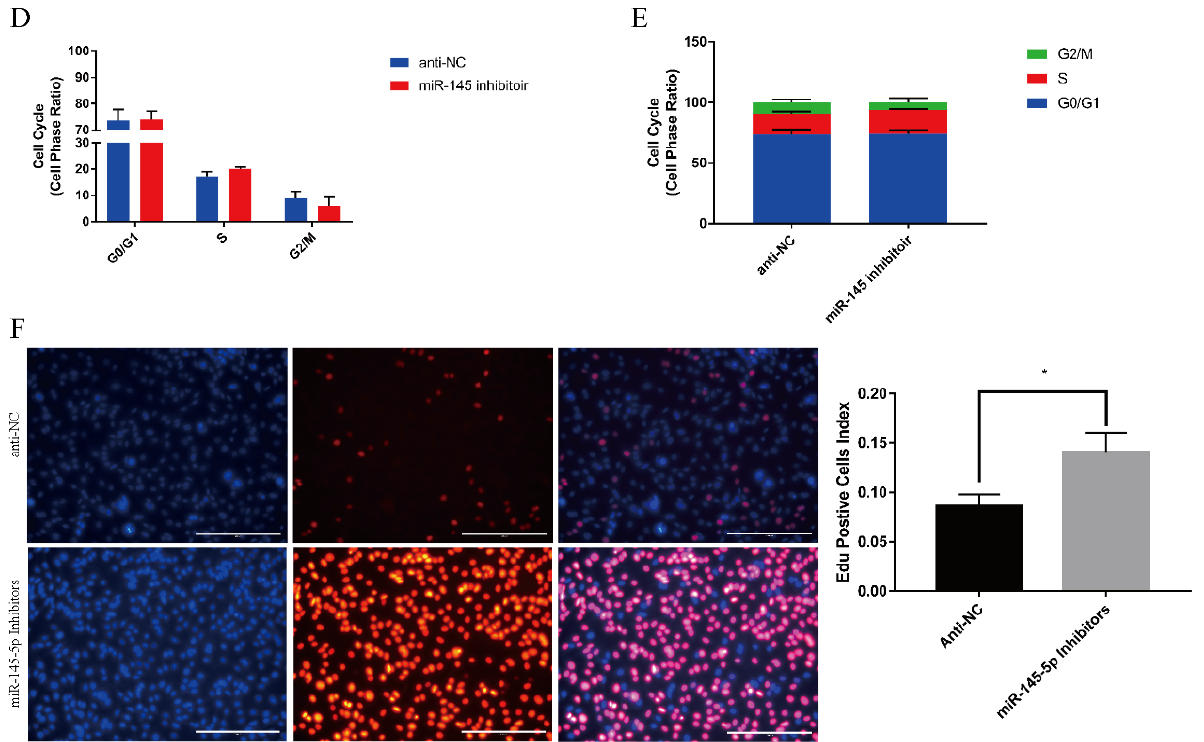
Figure 2. miR-145-5p knockdown promotes goat HFSC proliferation. ( A ) RT-qPCR quantified the